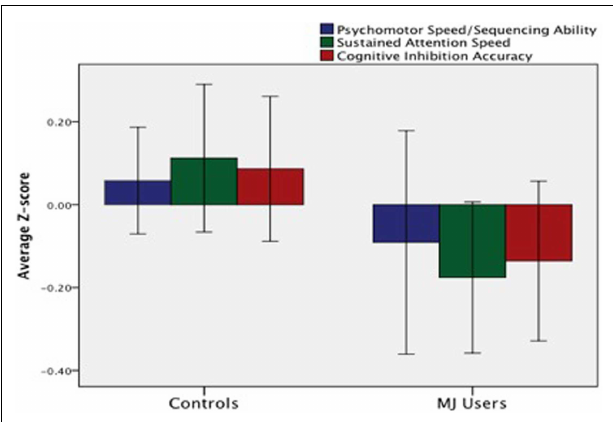
FIGURE 7 | Deficits in mean z -score psychomotor speed, sustained attention, and cognitive inhibition were observed in emerging MJ ( n = 23) users compared to normal controls ( n = 35) following a minimum of 1week of abstinence (adapted from Lisdahl and Price, 2012)